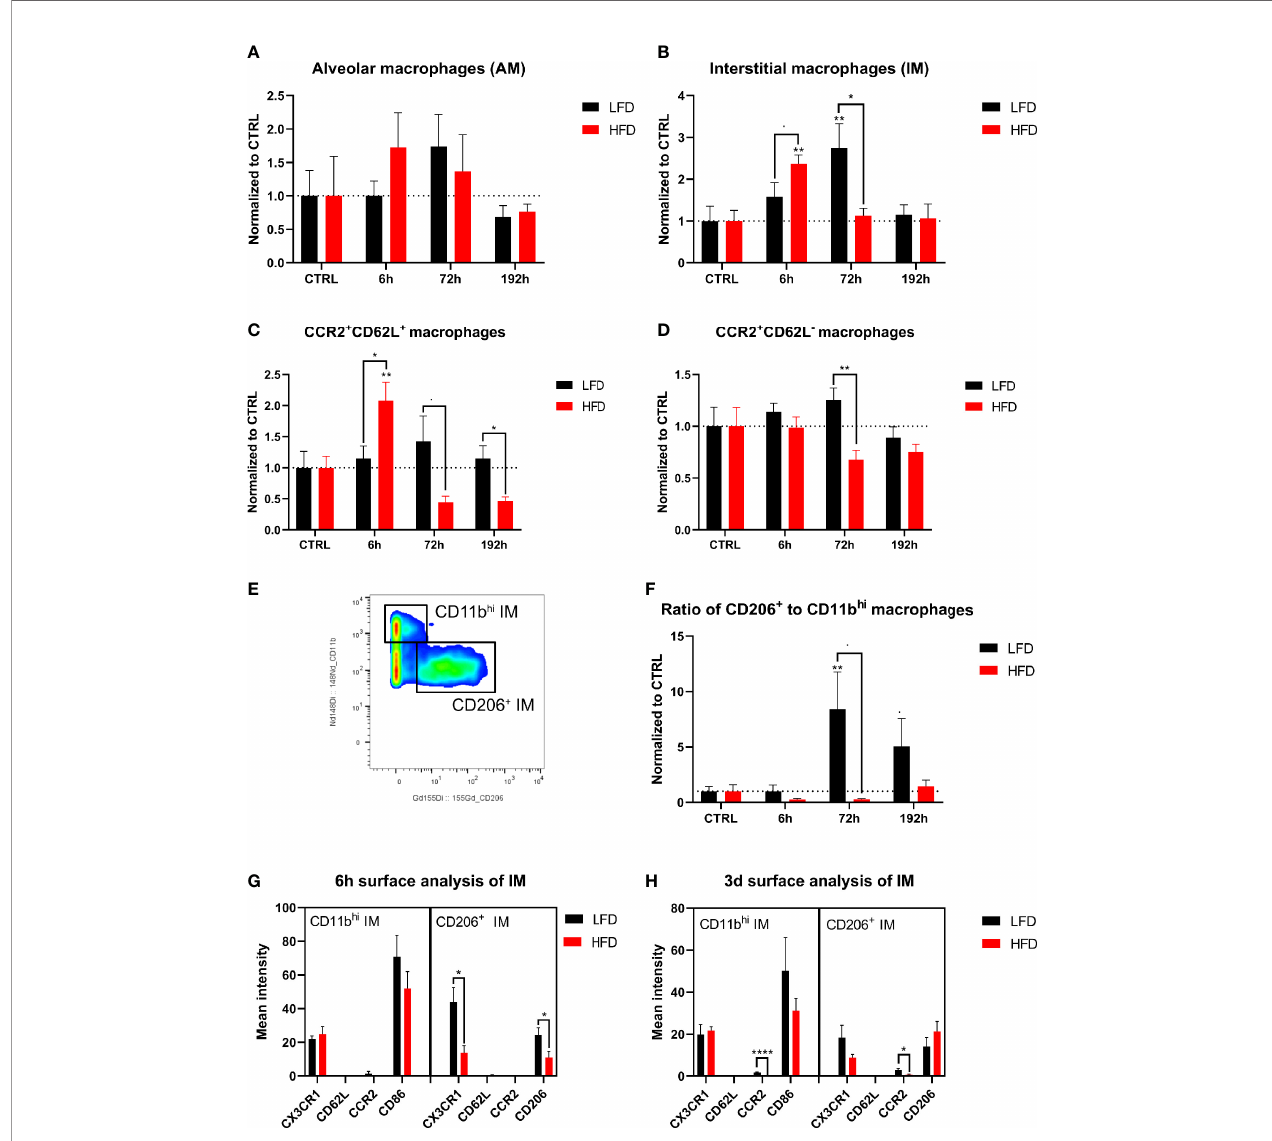
FIGURE 8 | CyTOF analysis of macrophage population in the lung of lean and obese mice after trauma. Baseline-corrected (ratio) timelapse for alveolar macrophages (AM) (A) , interstitial macrophages (IM) (B) , CCR2 + CD62L + macrophages (C) , and CCR2 + CD62L - macrophages (D) . A gating example is showing the differentiation between CD11b hi and CD206 + macrophages (E) and is used to calculate the ratio of CD206 + to CD11b hi macrophages over the timelapse of the study (F) . Analysis of the surface markers CX3CR1, CD62L, CCR2 as well as CD86 or CD206 on CD11b hi and CD206 + macrophages is depicted 6 h post trauma (G) , as well as 72 h post trauma (H) . Statistics: two-way ANOVA with an uncorrected Fisher ’ s LSD test as follow-up was used to compare the level to the respective CTRL, signi fi cance indicators are displayed directly above the bar; unpaired two-tailed Student ’ s t -test was used for comparison of lean and obese mice at a speci fi c time point, signi fi cance indicators are displayed next to the connector line. indicates p ≤ 0.1, * indicates p ≤ 0.05, ** indicates p ≤ 0.01, p**** indicates p ≤ 0.0001. Sample sizes: LFD CTRL = 5, LFD 6 h = 5, LFD 72 h = 6, LFD 192 h = 5, HFD CTRL = 5, HFD 6 h = 5, HFD 72 h = 4, HFD 192 h = 5. Data are displayed as mean ±